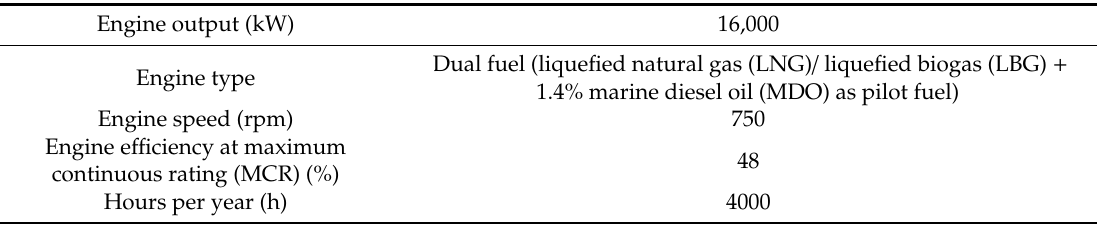
Table 1. RoPax vessel basic